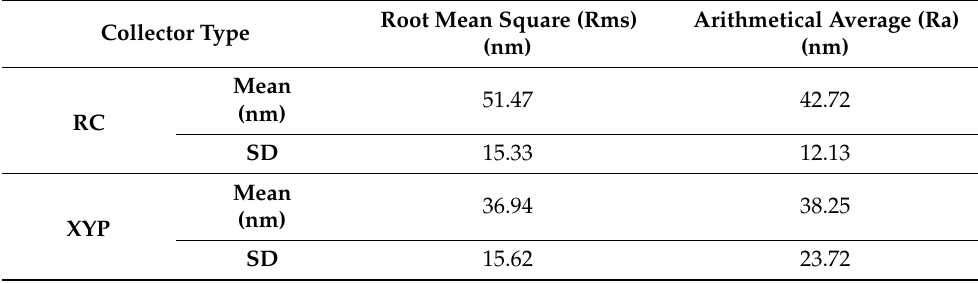
Table 1. Surface roughness of the samples collected using the RC and